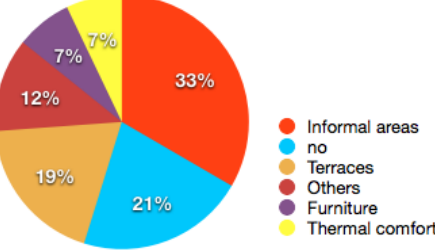
Figure 9. Question: is there something you have seen in other offices that you would appreciate having in yours?